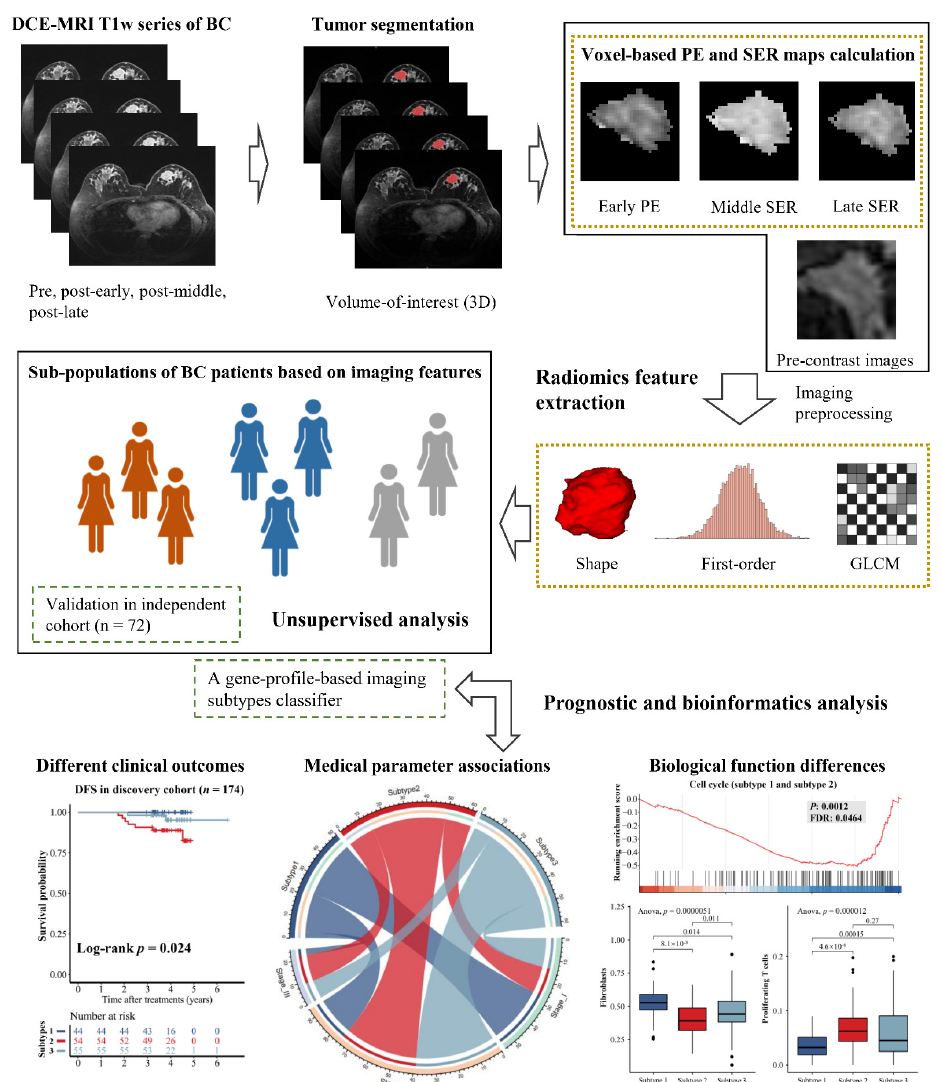
Figure 1. Workflow of this unsupervised analysis based on DCE-MRI radiomics features in BC patients. In this study, we took advantage of DCE-MRI techniques and calculated the voxel-based percentage enhancement (PE) and signal enhancement ratio (SER) maps for each patient. Two independent radiogenomics cohorts ( n = 246) were collected to identify and validate the novel imaging subtypes. The clinical and biological associations of DCE-MRI subtypes were further